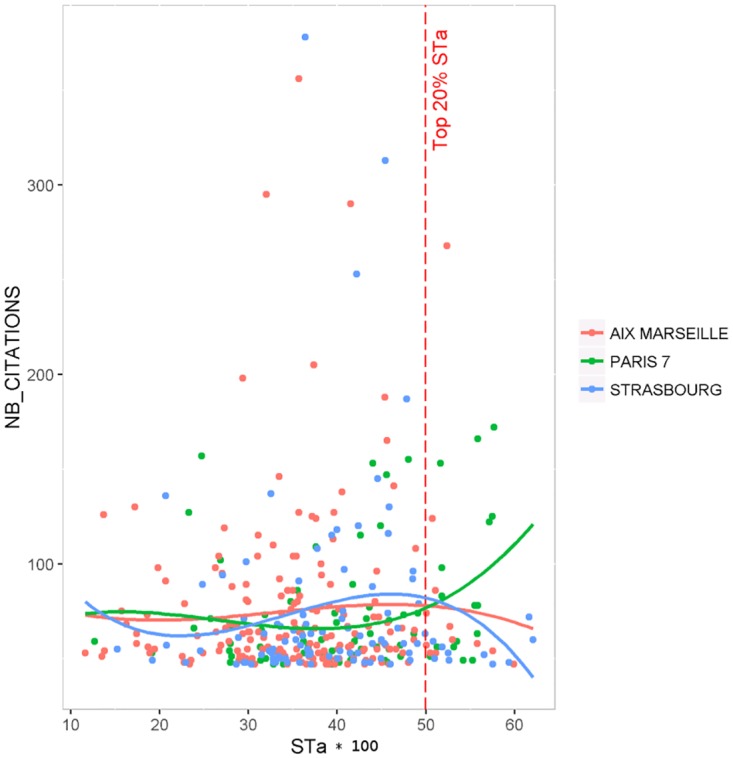
Article interdisciplinarity index STa and number of citations in a 3 year window for Aix-Marseille, Strasbourg and Paris 7 Universities.Displayed articles are in the top 20% percentile of the most cited publications. A polynomial curve with degree 3 is fitted for each university.